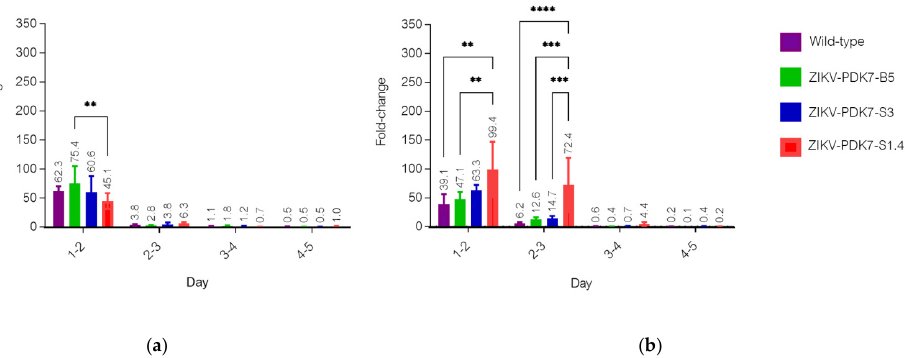
Figure 6. Ratios of replication rate per day of ZIKV isolates. The fold-changes of replication rate were calculated from viral growth kinetics in C6/36 ( a ) and Vero cells ( b ). Bar graphs represent the ratio of increasing titers of ZIKV isolates per day between day 1 and day 5, and the error bars rep- resent the SD. Fold-changes of viral yield per day are shown in the figure. A significant difference is calculated by using two-way ANOVA with Tukey’s multiple comparisons test. p -values: 0.1234 = ns; 0.0021 **; < 0.0002 ***; < 0.0001 ****. 3.4. Delayed Start to Replication of the Small-Plaque Isolate in Vero Cells Is Due to Diminished Capability in Cell Entry The two small-plaque isolates ZIKV-PDK7-S3 and ZIKV-PDK7-S1.4 contain the same three unique non-synonymous mutations in E and NS3 proteins. We hypothesized that the two mutations on the E protein (A310E and E393K) affect cell receptor binding and subsequently viral entry into Vero but not C6/36 cells. Therefore, viral entry into the C6/36 and Vero cells of each isolate was determined after 24 dpi by real-time PCR to examine the viral copies per cell of each ZIKVs infected group. The results showed a significant reduction in the small-plaque variant, ZIKV-PDK7-S1.4, entry into Vero but not C6/36 cells, compared to the parental ZIKV and the big-plaque isolate (Figure 7a,b), whereas the degree of entry of the big-plaque isolate was comparable to the wild-type ZIKV. ( a ) ( b ) Figure 7. Viral entry into C6/36 ( a ) and Vero ( b ) cells was determined by real-time PCR. The viral RNA copies number per cell was determined by real-time PCR. The cells were infected with ZIKVs, wild-type, ZIKV-PDK7-B5, and ZIKV-PDK7-S1.4, at an MOI of 10. After viral adsorption, the viruses were removed and treated with acid glycine to inactivate the remaining un-internalized viruses.